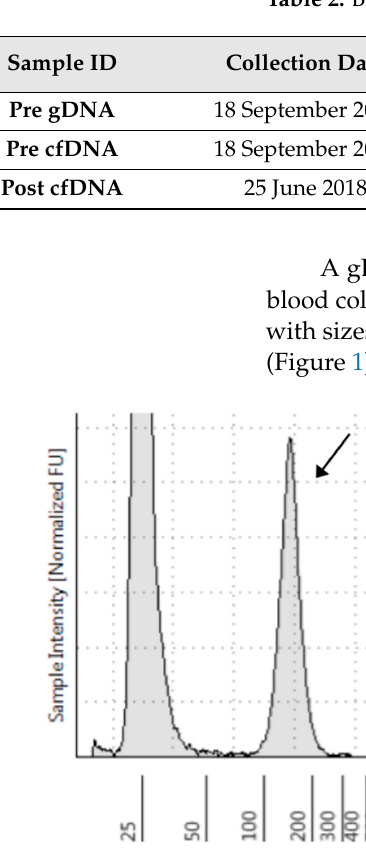
Figure 1. TapeStation analysis of DNA extracted from plasma collected before ( left ) and after ( right ) treatment with ribociclib plus letrozole. Arrows indicate cfDNA fragments (with a peak at ~150 bp).